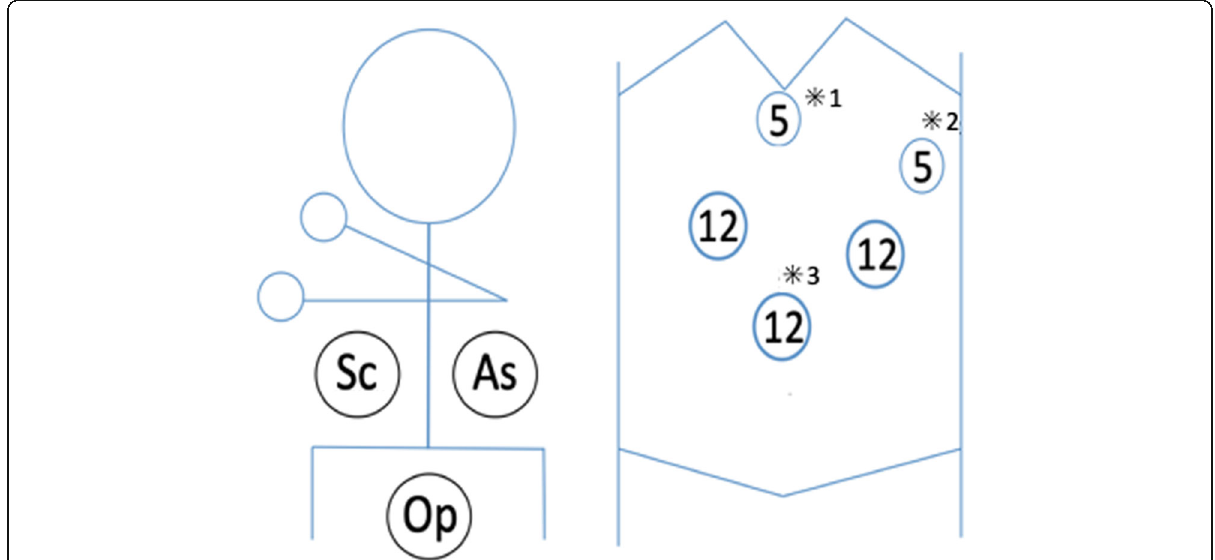
Fig. 2 The patient is under general anesthesia in the lithotomy position and undergoes a laparoscopic surgery with a co-axial approach using four ports and a liver retractor (*1). The left hypochondrium port is for the assistant surgeon (*2), and the umbilicus port is for laparoscopy (*3). Op, operator; As, assistant surgeon; Sc,